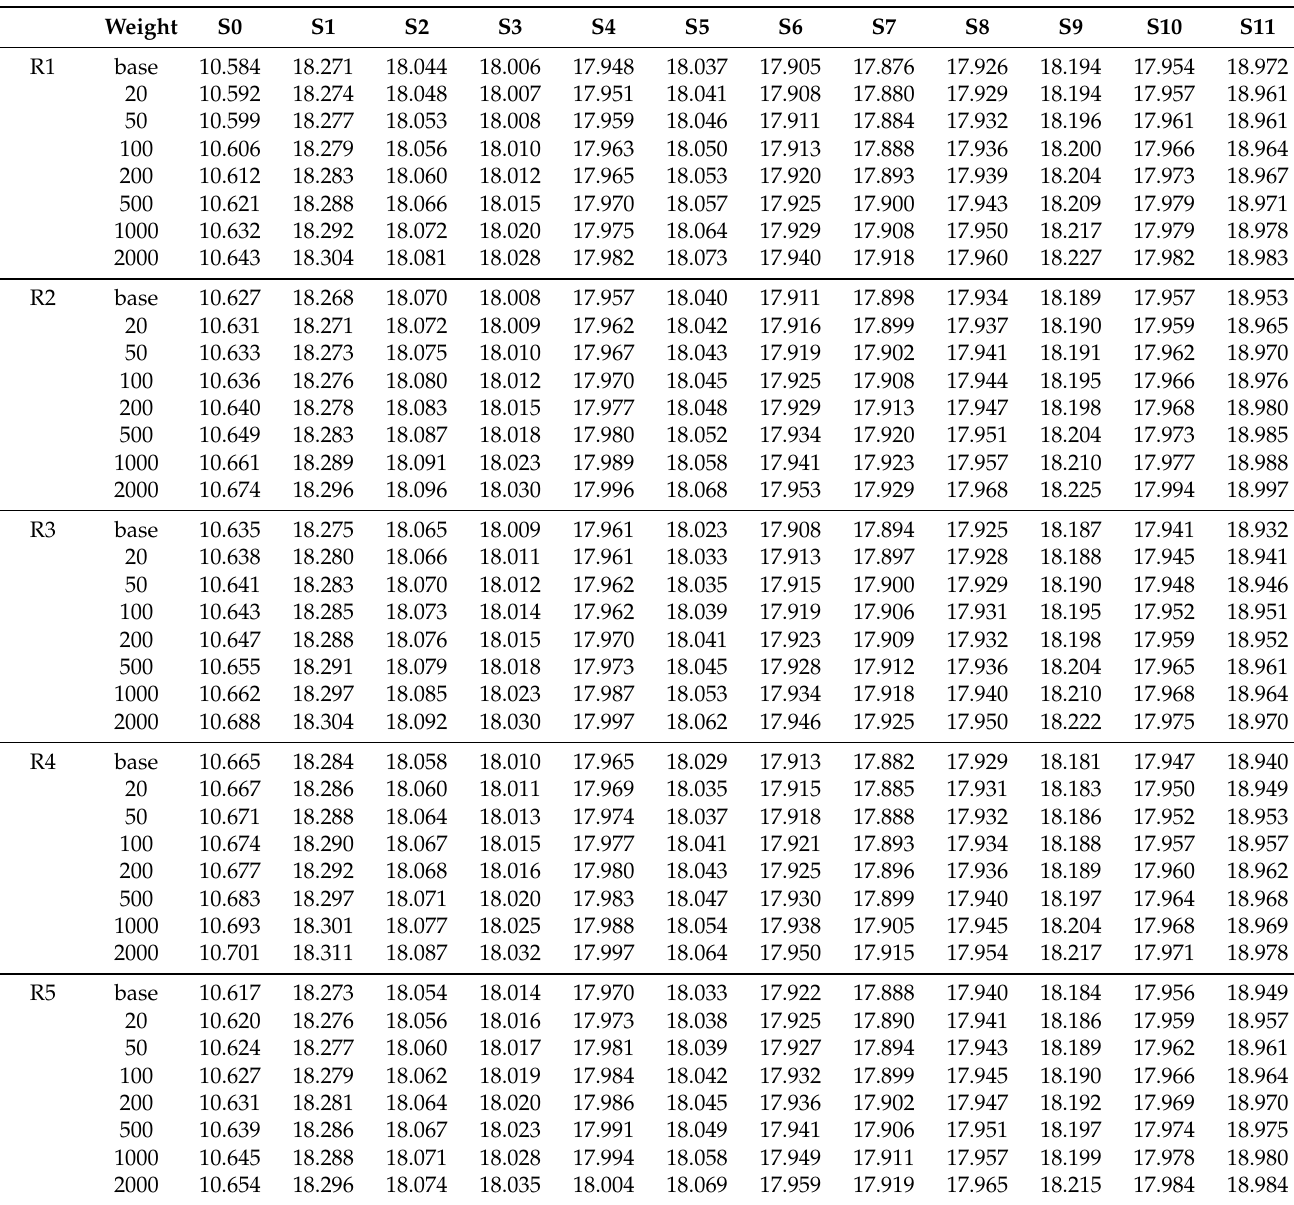
Table 4. Plantar insole— foot size 43 (27